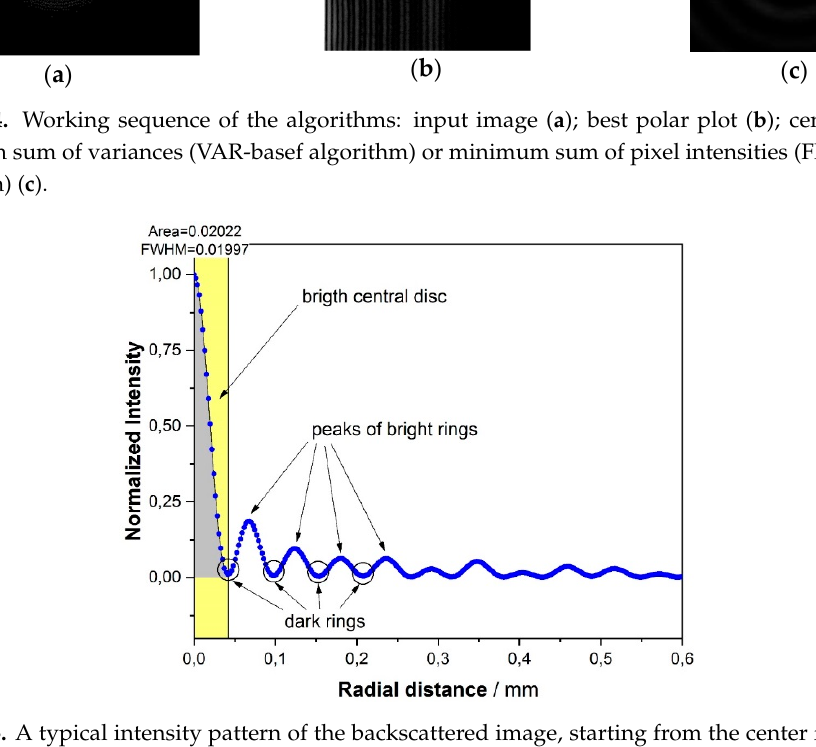
Figure 15. A typical intensity pattern of the backscattered image, starting from the center found by using one of the algorithms and moving towards the periphery of the same image.